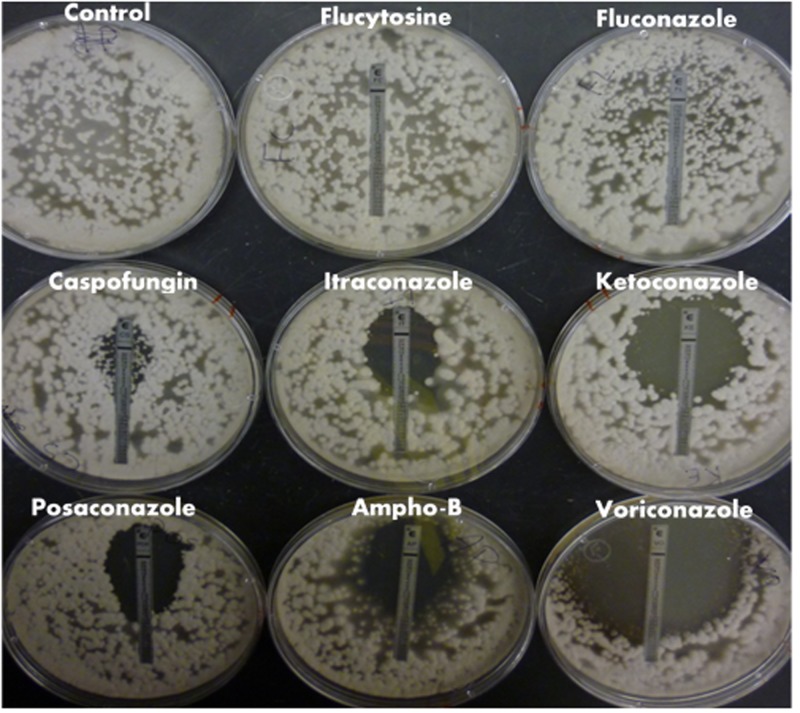
Magnaporthe oryzae drug susceptibility to common classes of medical antifungals. E-test strips were used to test M. oryzae susceptibility and determine the MIC to common antifungals belonging to different classes of drug. Plates were allowed to grow at 27°C for 96 h. The MIC was determined based on the ellipse of non-growth intersecting with the drug gradient marked on the test strip.